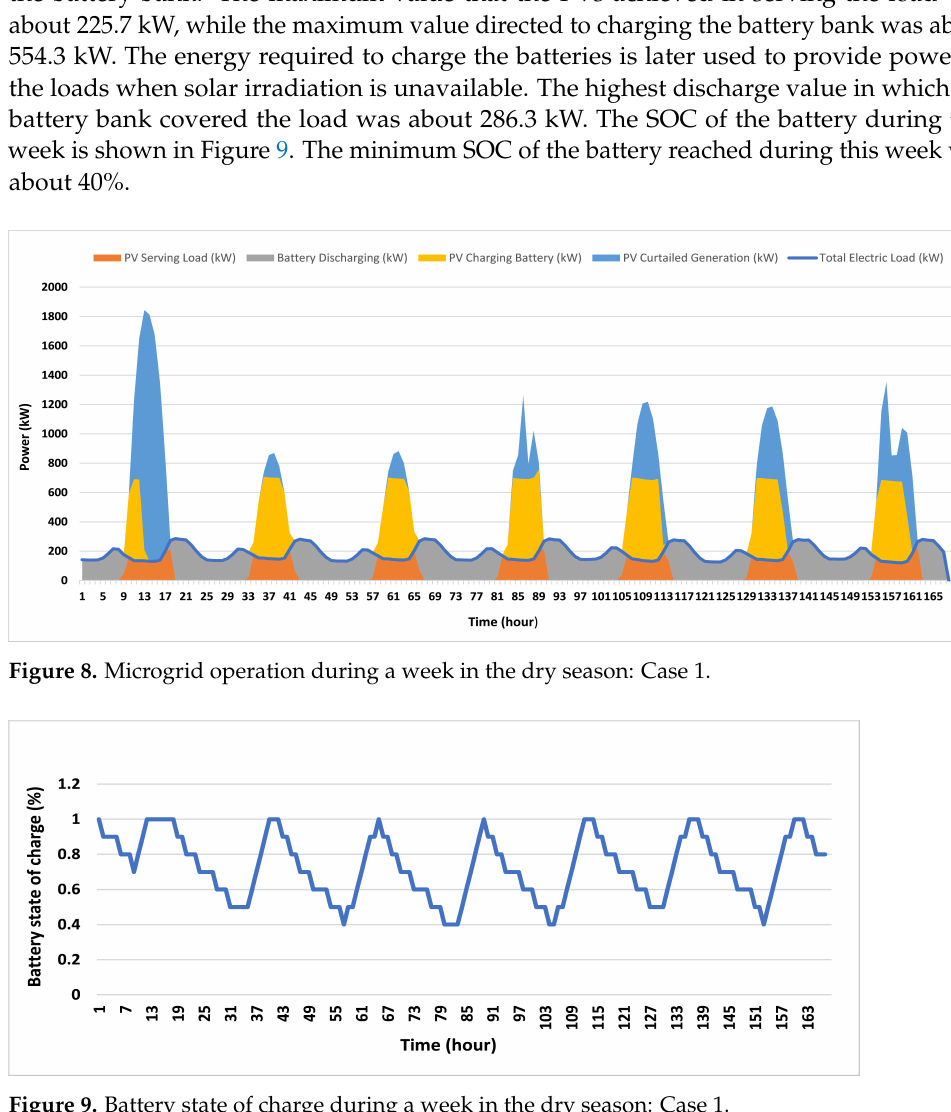
Figure 9. Battery state of charge during a week in the dry season: Case